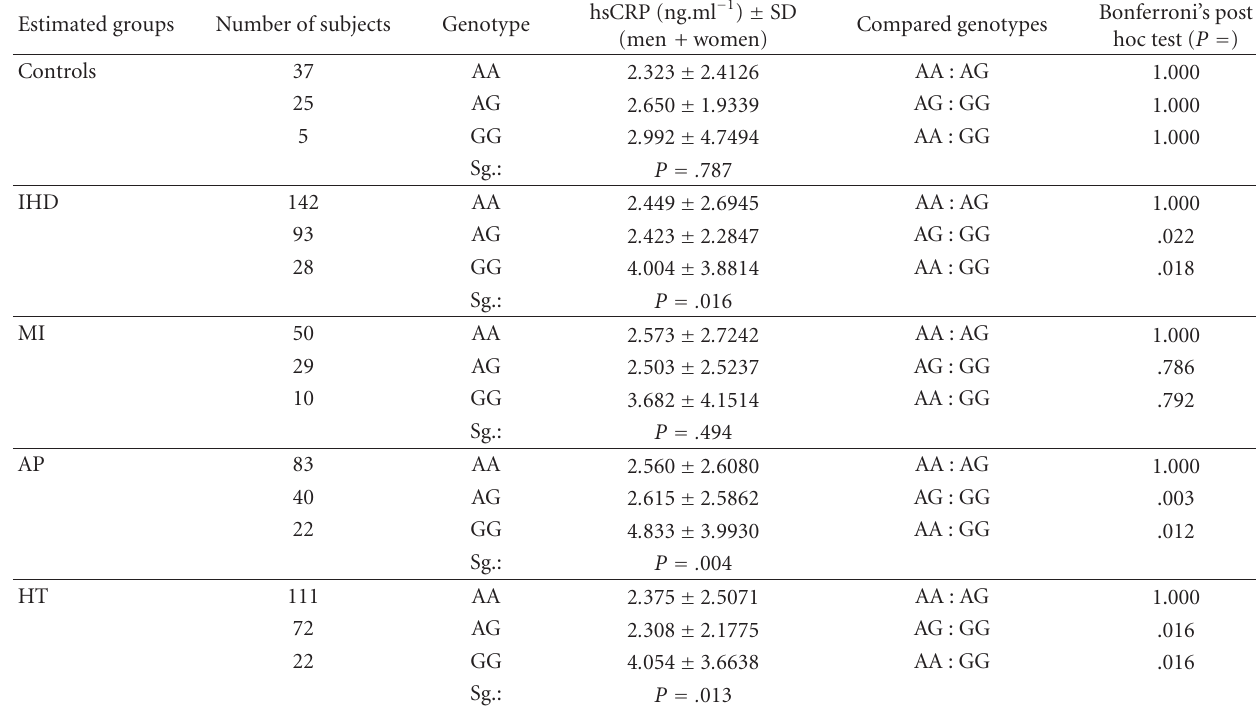
Table 2: Serum levels of hsCRP in patients with IHD, MI, AP, and HT in relation to the tested MCP-1 -2851 (A/G) SNP. Legend: IHD: ischemic heart disease; MI: myocardial infarction; AP: angina pectoris; HT: hypertension; Sg.: significance; SD: standard deviation. Estimated